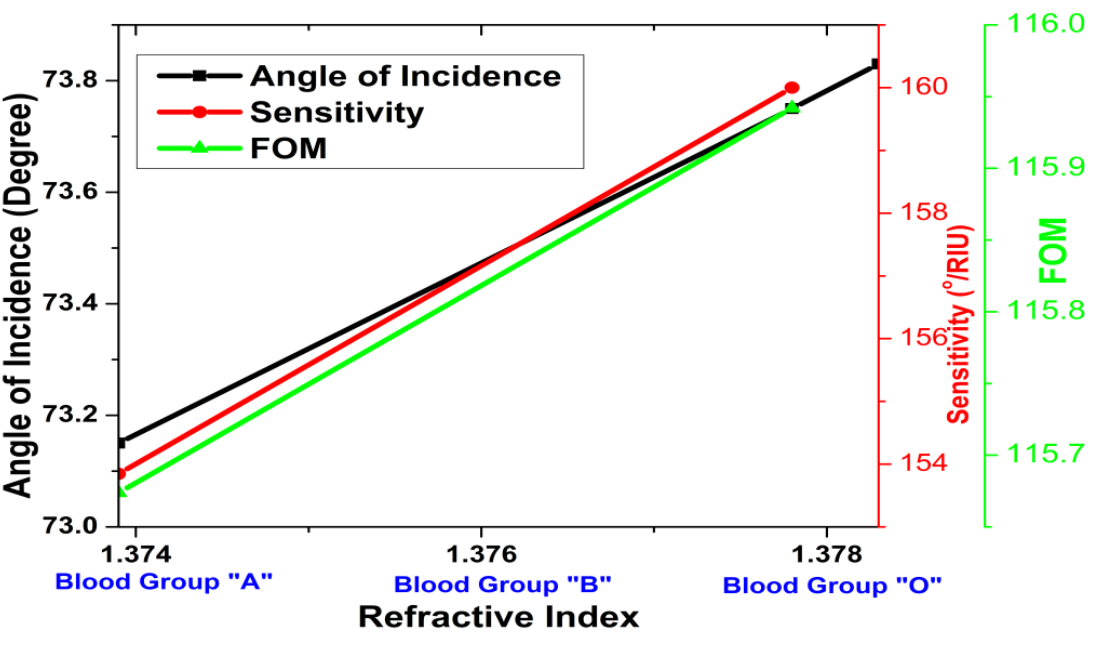
Figure 4. Proposed S.P.R. performance parameters (F.O.M, Sensitivity, Incident Angle) with respect to RI of Blood group samples “A”, “O” and “B”.